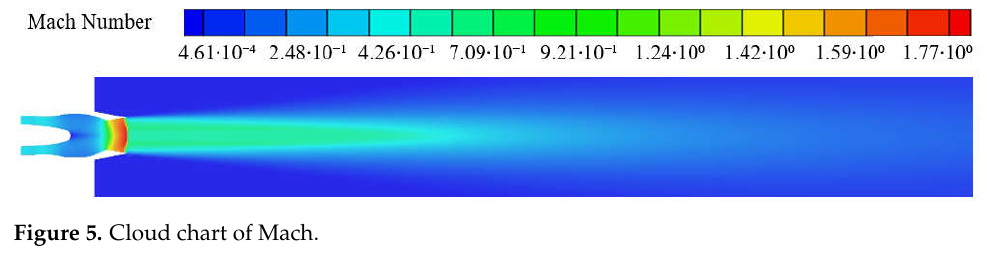
Figure 4. Cloud chart of total temperature.